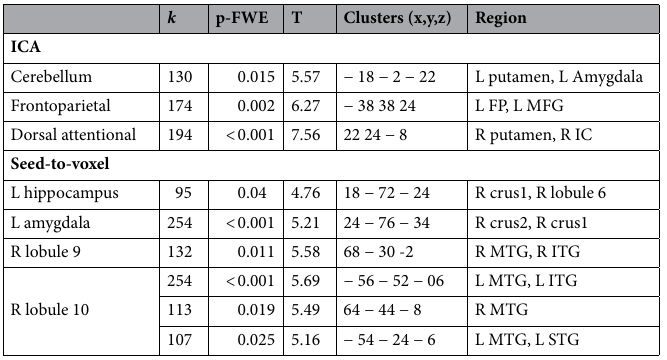
Table 3. Significant ICA and seed-to-voxel positive contrasts exercise > rest, post > pre. FP: frontal pole; FWE: family wise error; IC: insular cortex; ITG: inferior temporal gyrus; k: spatial extent (voxel) ; MFG: middle frontal gyrus; MTG: middle temporal gyrus; SMG: supramarginal gyrus; STG: superior temporal gyrus.